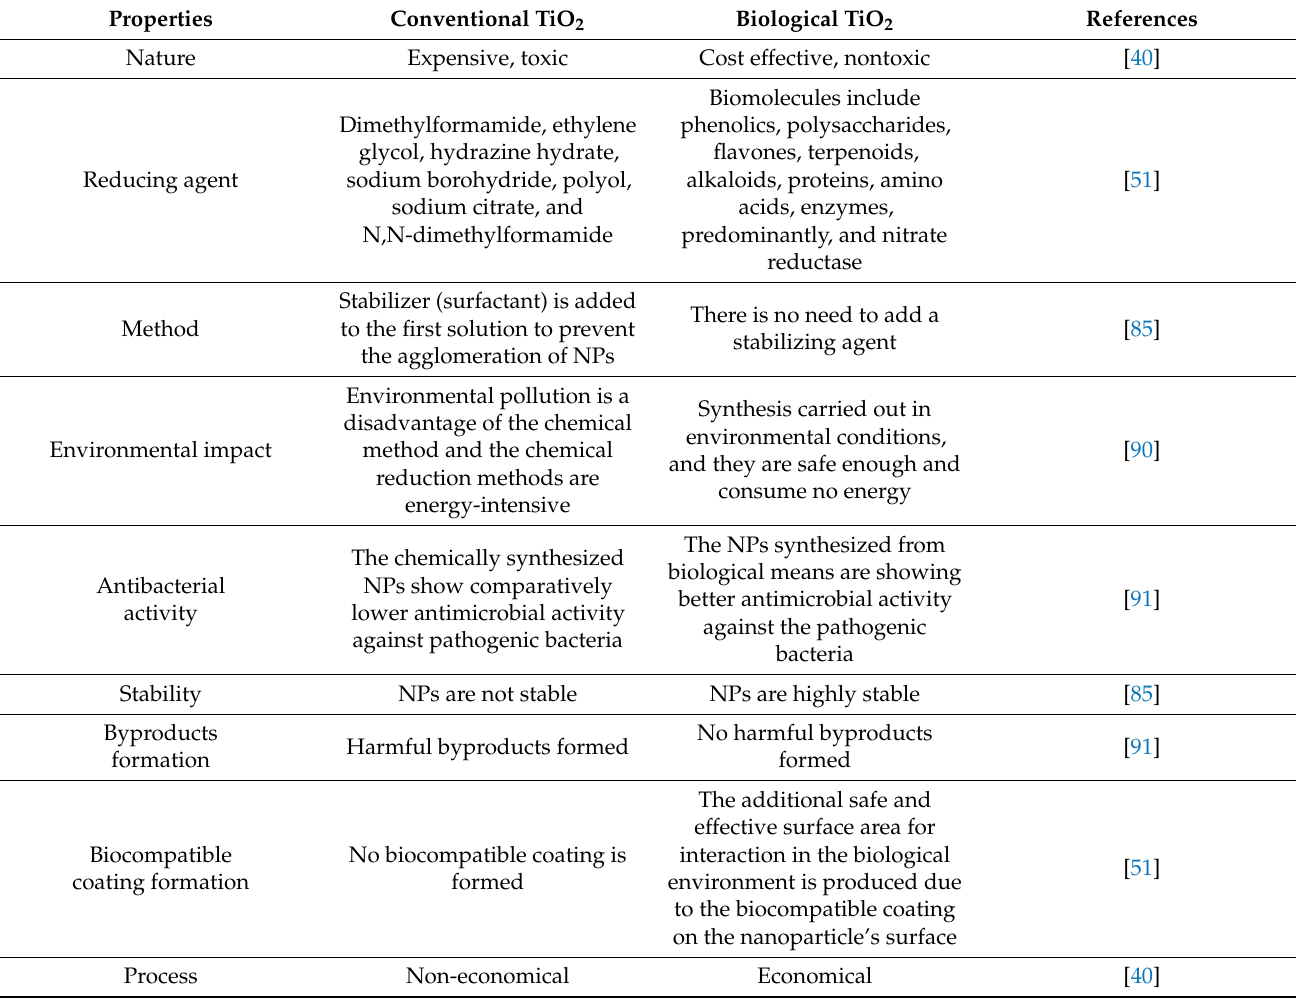
Table 1. Comparative differences between conventional and biological TiO 2 NPs